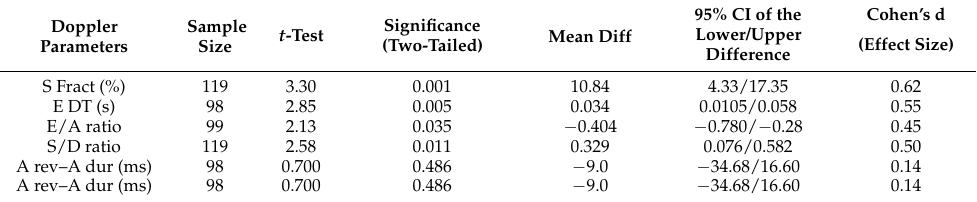
Table 4. Difference and effect size of the difference in the main Doppler parameters between the two groups, with the maximum VO 2 >14 vs. ≤ 14